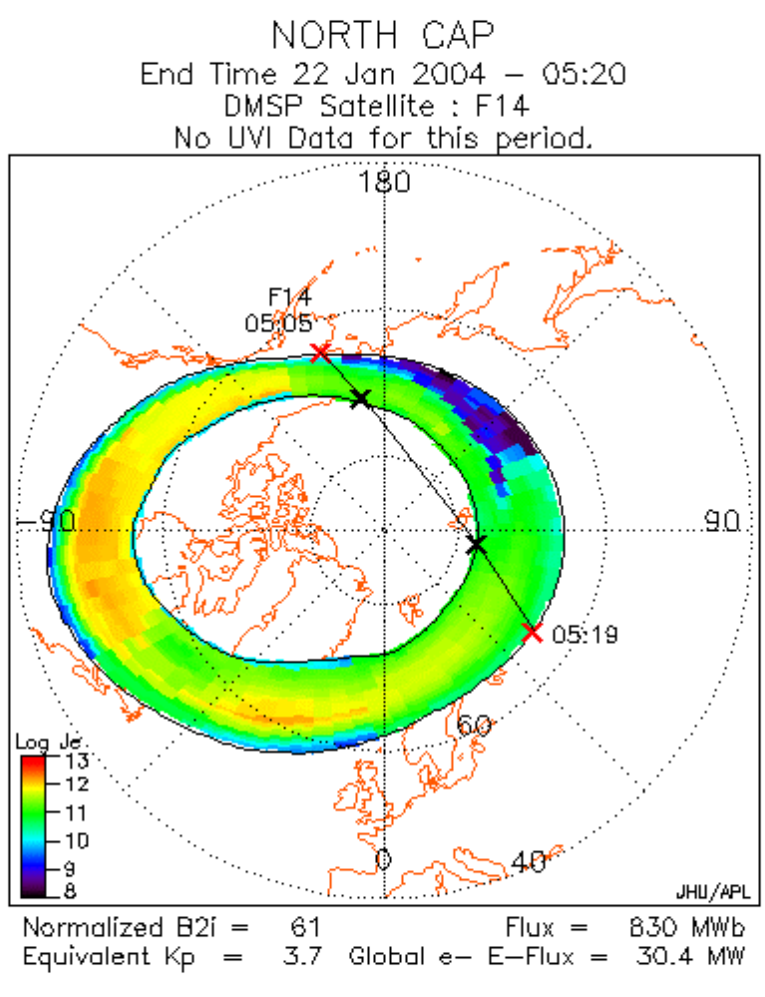
Fig. 11. Model of auroral oval at the beginning of Ps6 activity in local time–latitude (geographic) coordinates. Fig.11. Model of auroral oval at the beginning of Ps6 activity in local time – latitude (geographic) coordinates. the disturbances in the geomagnetic Y-component (Ps6 mag- netic pulsations) associated with the (cid:127)